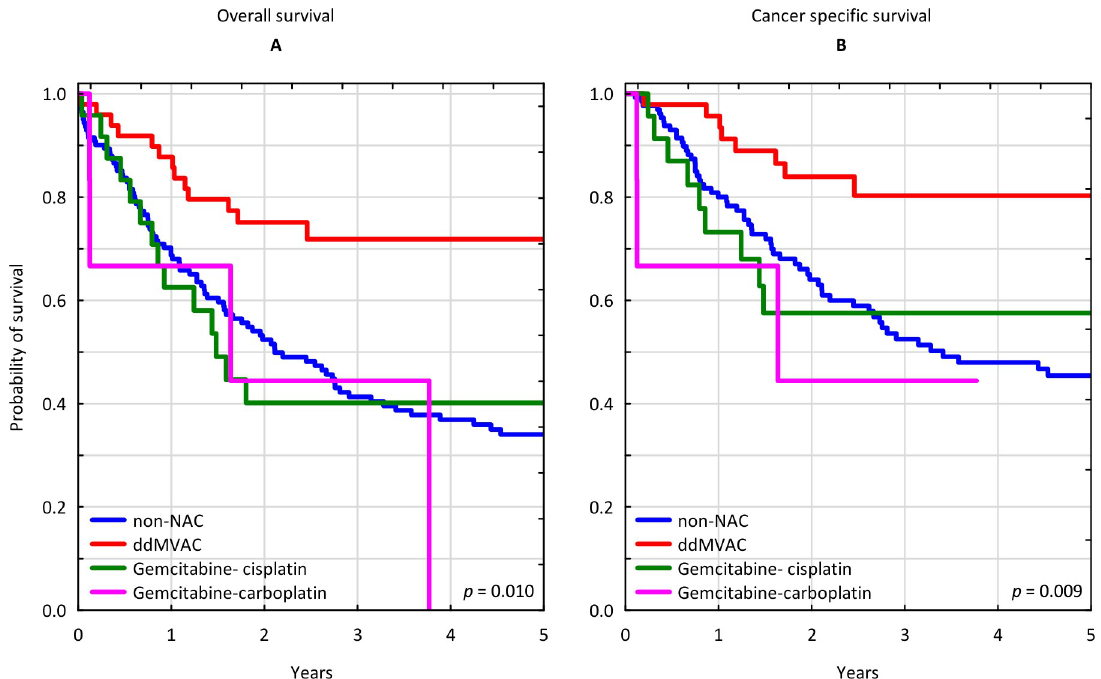
Fig 2. Survival analysis stratified by neoadjuvant chemotherapy regimen. (A) Kaplan-Meier curves for overall survival stratified by neoadjuvant chemotherapy regimen. (B) Kaplan-Meier curves for cancer specific survival stratified by neoadjuvant chemotherapy regimen. ddMVAC: dose-dense methotrexate, vinblastine, doxorubicin and cisplatin; NAC: neoadjuvant chemotherapy.